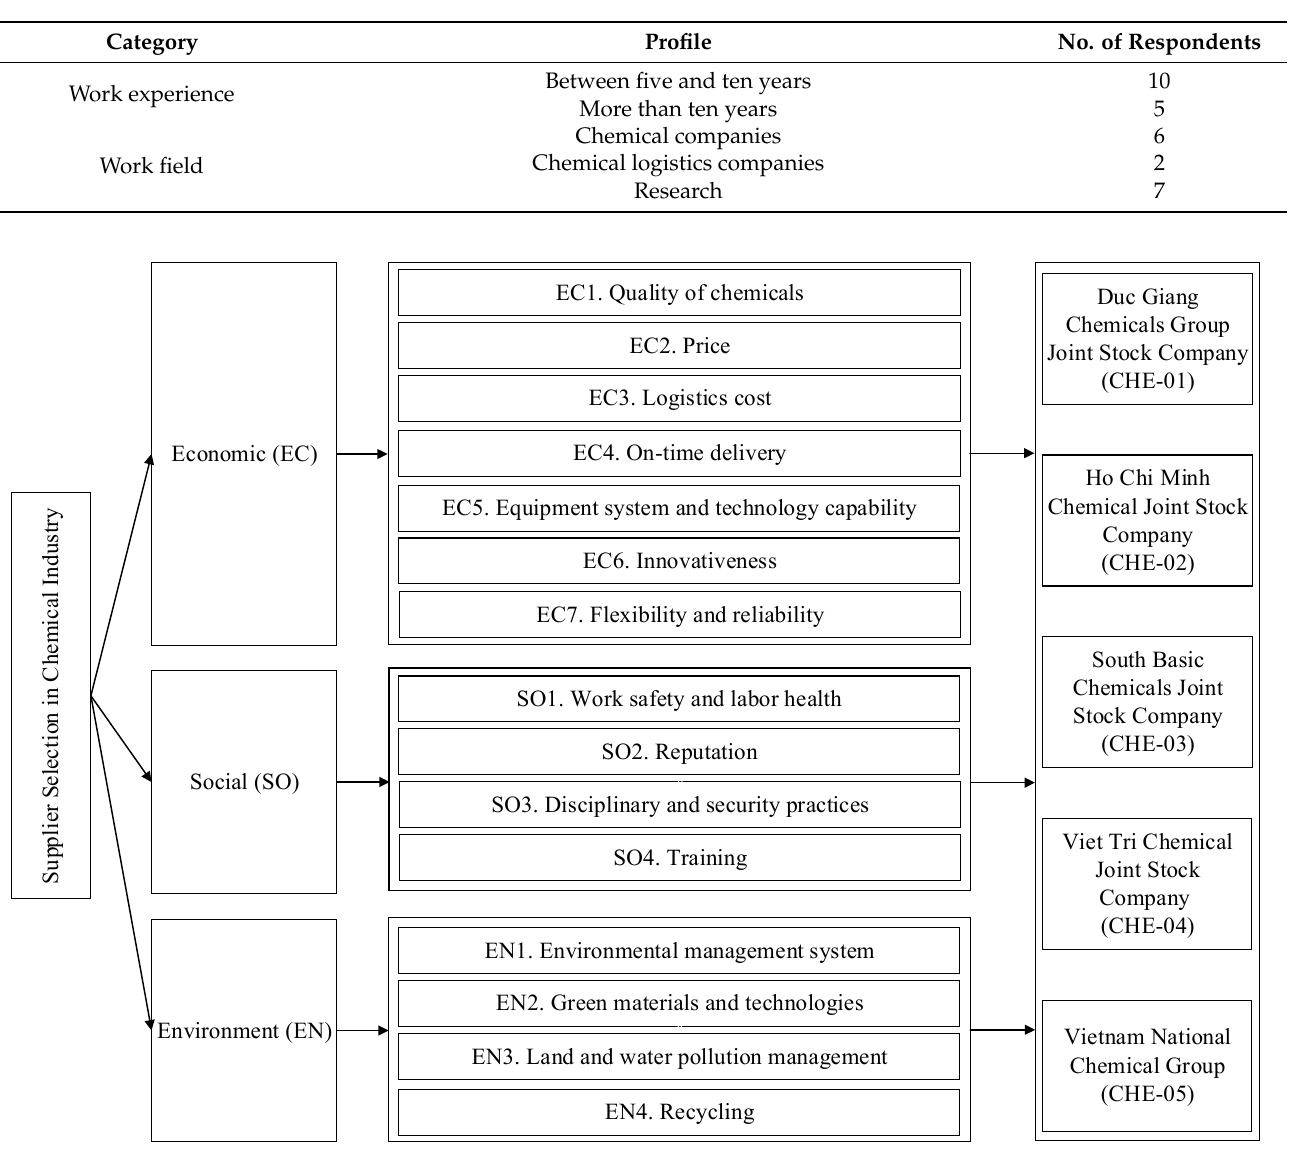
Figure 2. Hierarchical structure.